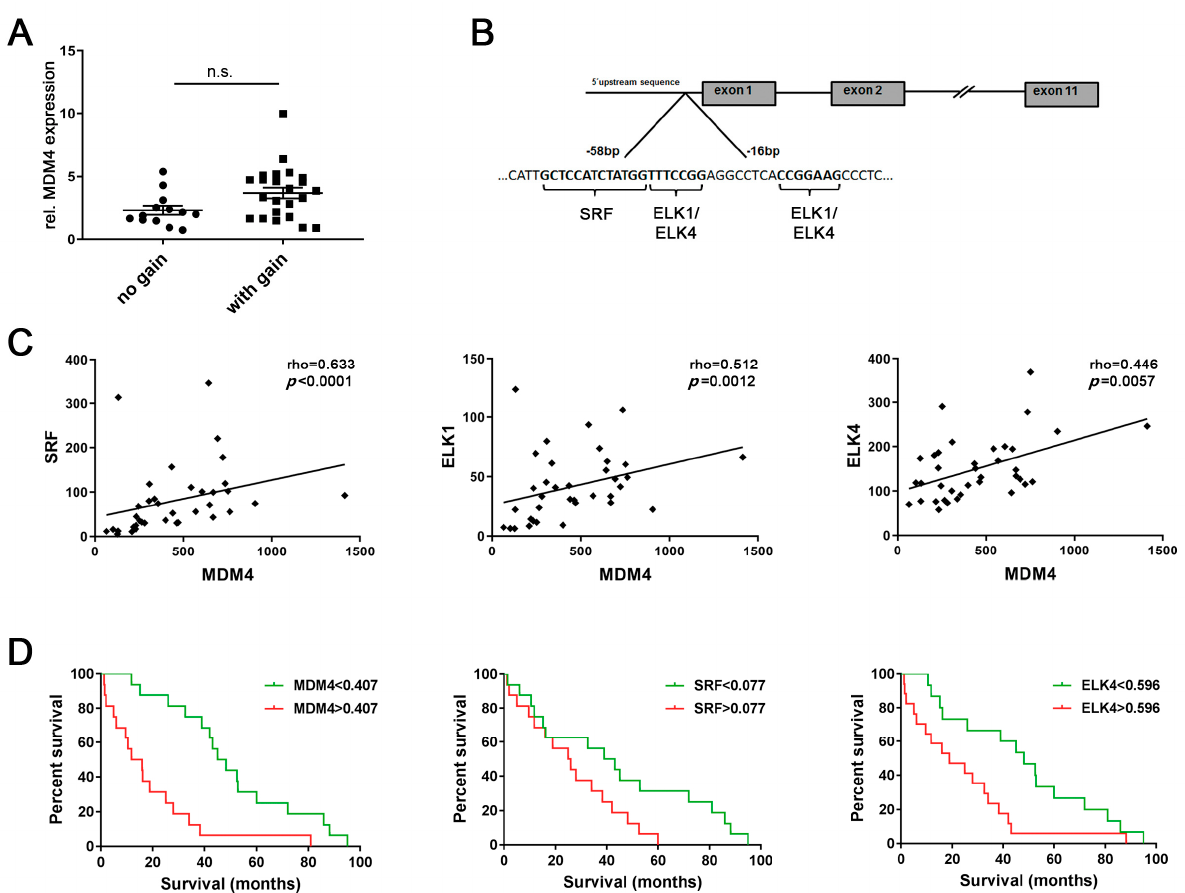
Figure 1. Aberrant transcriptional activation may be involved in upregulation of mouse double minute homolog 4 ( MDM4 ) in human HCC. ( A ) Relative MDM4 mRNA expression in human hepatocellular carcinomas (HCCs) with balanced ( n = 13) and gained MDM4 ( n = 24) gene loci, respectively. Mann–Whitney U test: p > 0.05. ( B ) An in silico analysis of the basal MDM4 promoter region identified putative transcription factor binding sites for serum response factor (SRF), ELK1, and ELK4. ( C ) Expression profiling revealed a positive association between MDM4 mRNA and the expression level of the putative transcription factors SRF , ELK1 , and ELK4 in human HCC samples ( n = 37). ( D ) MDM4 , SRF , and ELK4 mRNA levels were associated with the survival probability of HCC patients in a second cohort ( n = 32). Each median expression level was used for stratification. Abbreviation: n.s., not statistically significant.